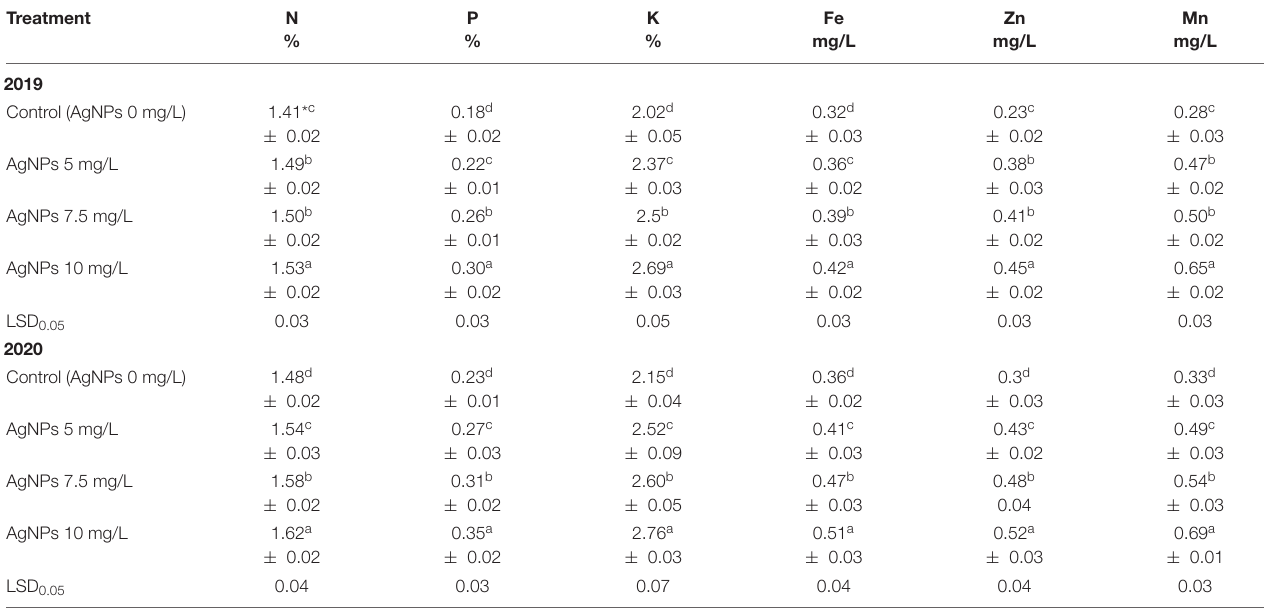
TABLE 5 | Influence of AgNPs spraying on “Eureka” lemon leaf composition from N, P, K, Fe, Zn, and Mn during 2019 and 2020.